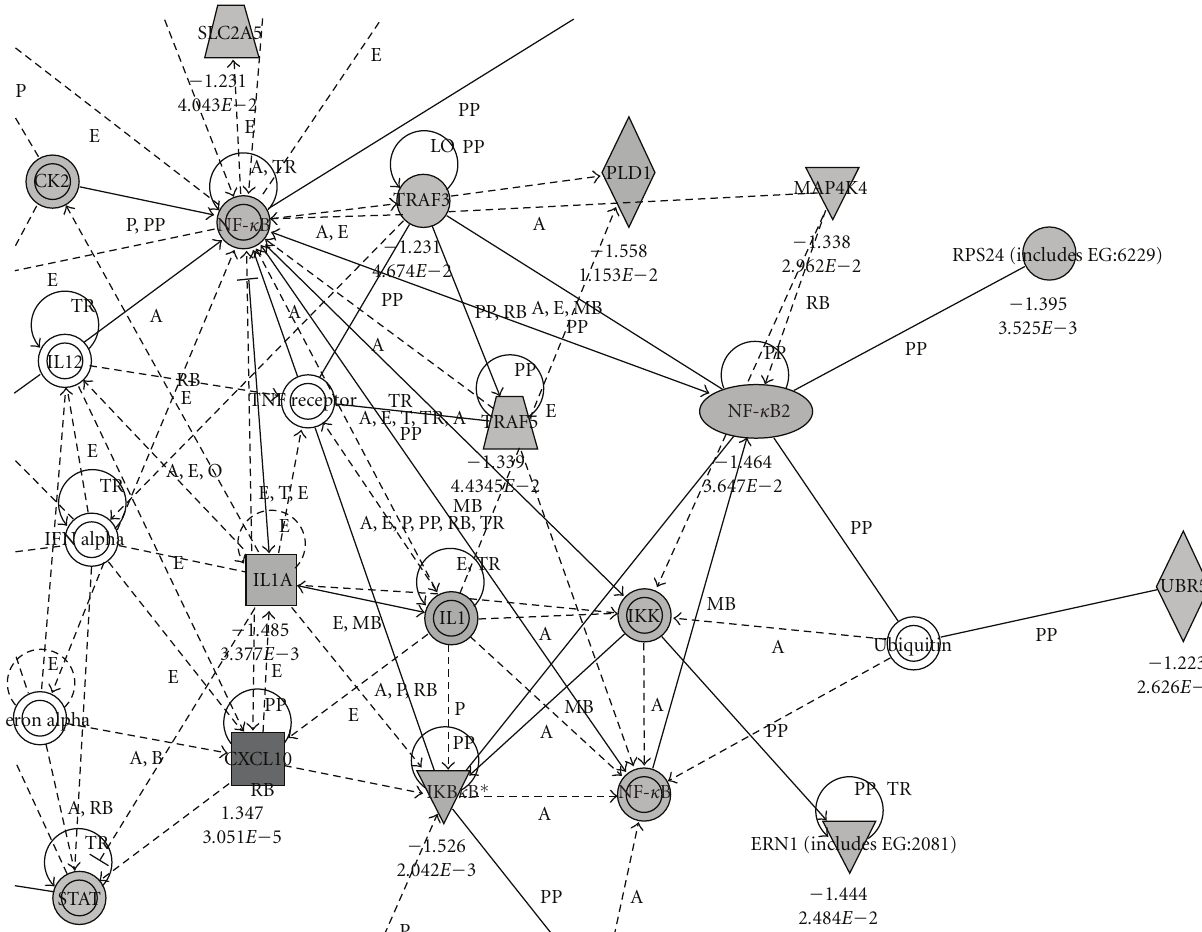
Figure 2: Placing datasets into a functional context using pathway analysis. Example transcriptional expression data were uploaded to the Ingenuity Pathway Analysis application (http://www.ingenuity.com/), and its knowledgebase was used to construct signaling networks on the basis of known interactions from the literature. These approaches can allow the visualization of networks associated with viral infection and identify signaling “hubs” which may act as master switches of the host